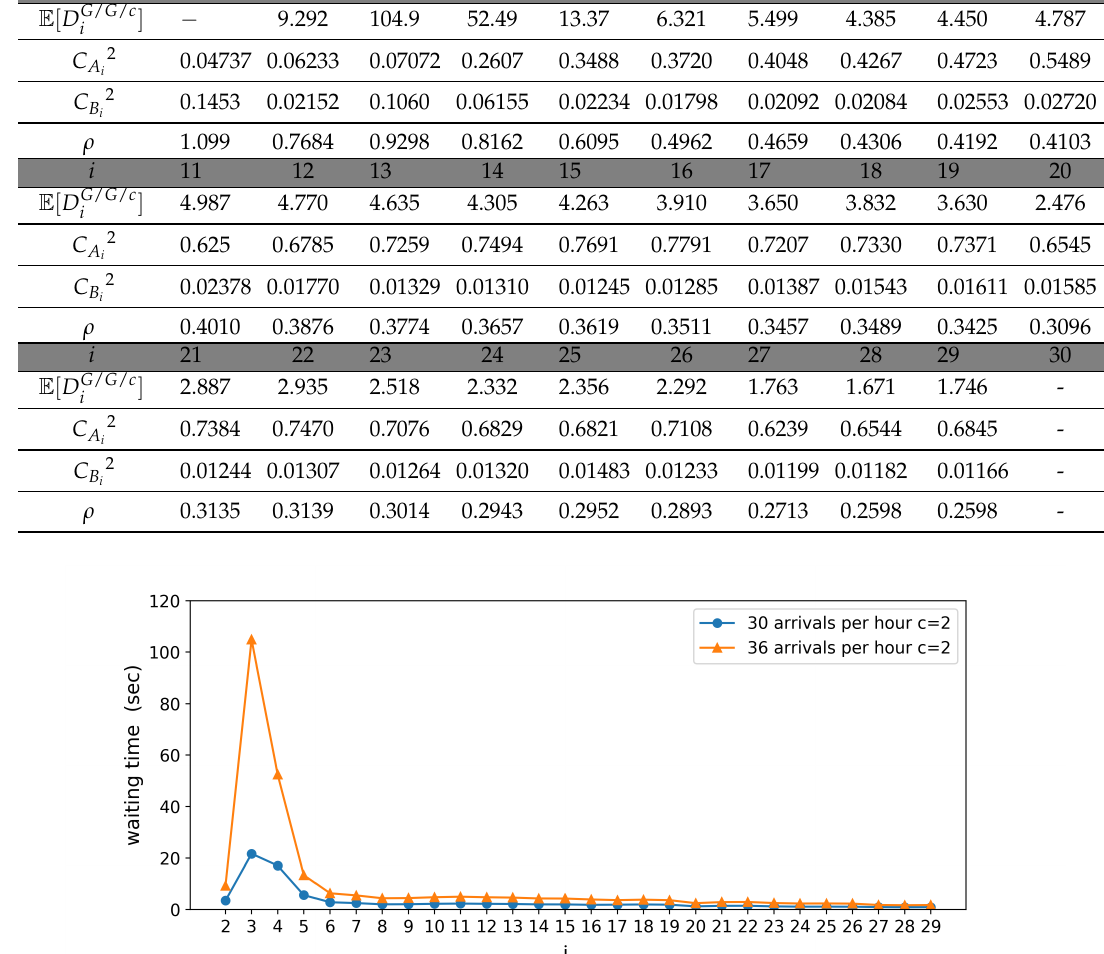
Figure 13. Comparison of the expected arrival delays for airspace capacity, c =